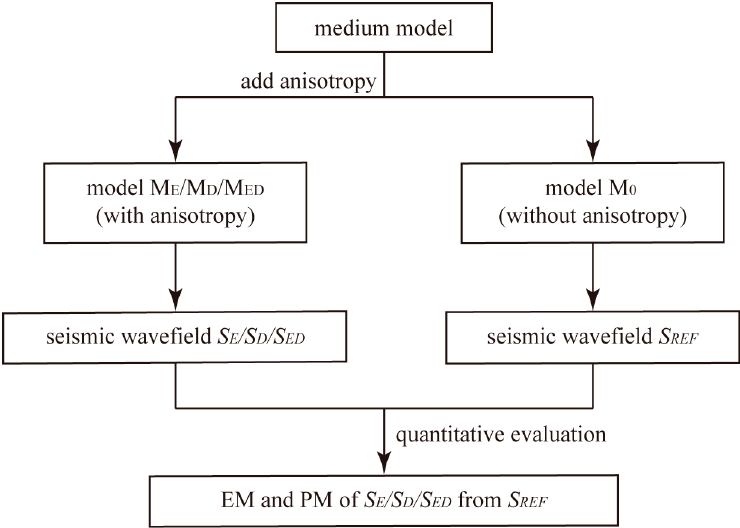
Figure 1. The flow chart of the proposed method for the analysis of anisotropy effects. The procedure of this method starts with adding anisotropy to the medium model, followed by the seismic wavefield forward modeling and quantitative evaluation.